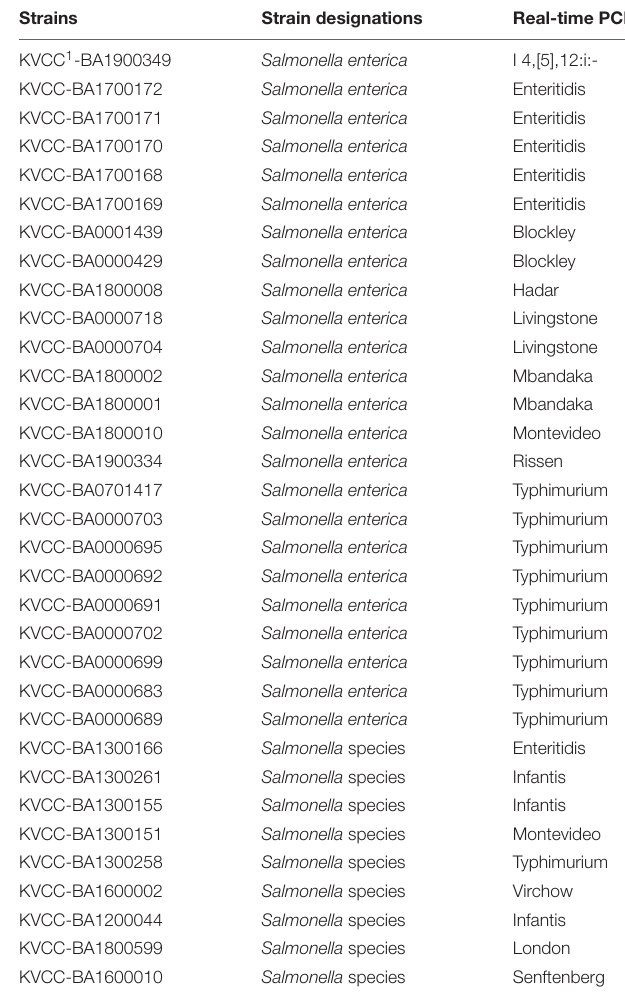
TABLE 5 | Serotyping results for isolates with unknown